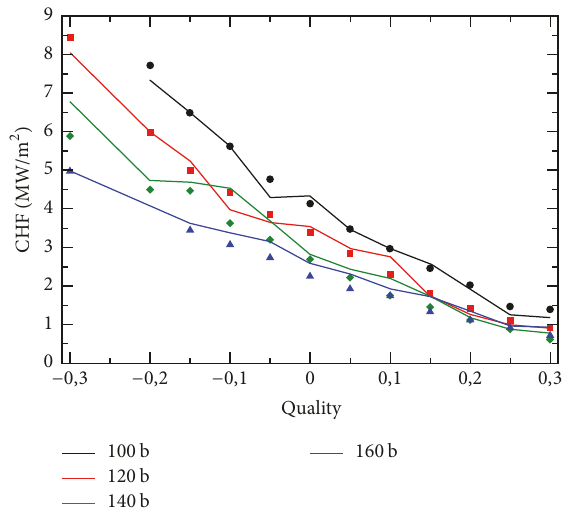
Figure 47: Tube diameter of 6mm. Experimental values are represented by points.